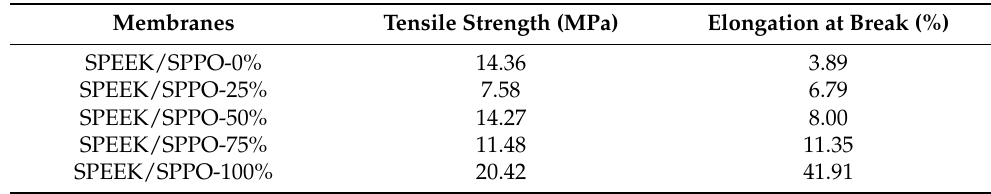
Table 2. Tensile strength and elongation at break of the fabricated membrane SPEEK/SPPO-0 to SPEEK/SPPO-100 (where 0, 25, 50, 75 and 100% represent the amount of SPPO into the SPEEK/SPPO blended membranes).